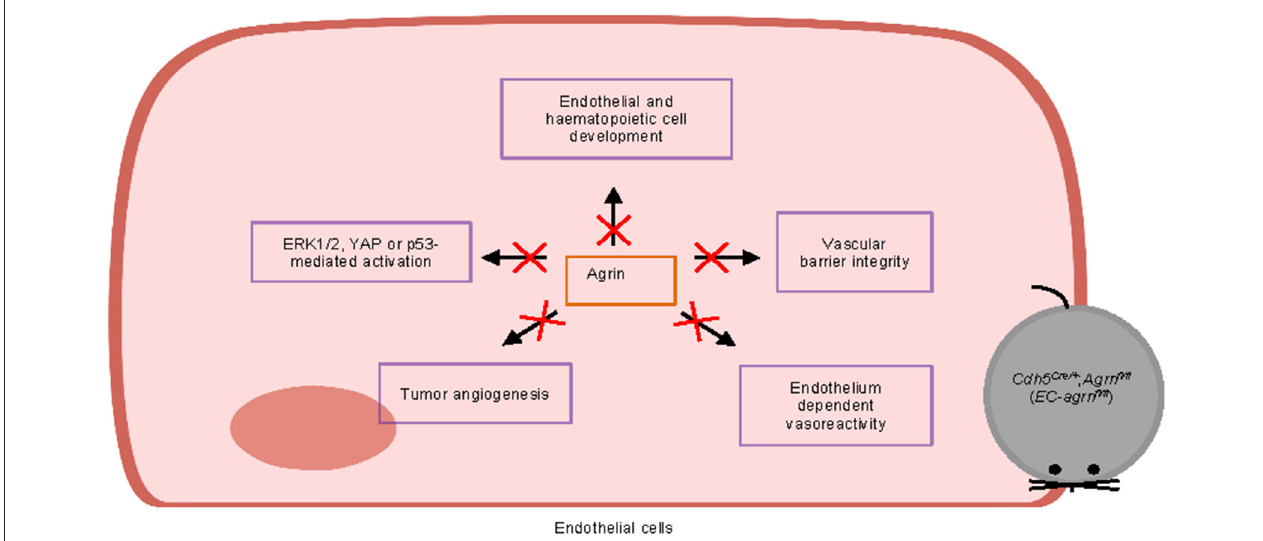
FIGURE 8 | Graphical summary of this study. Endothelial agrin is dispensable for endothelial and haematopoietic cell development, vascular barrier integrity, endothelium dependent vasoreactivity, tumor angiogenesis, and ERK1/2, YAP or p53-mediated activation in vivo